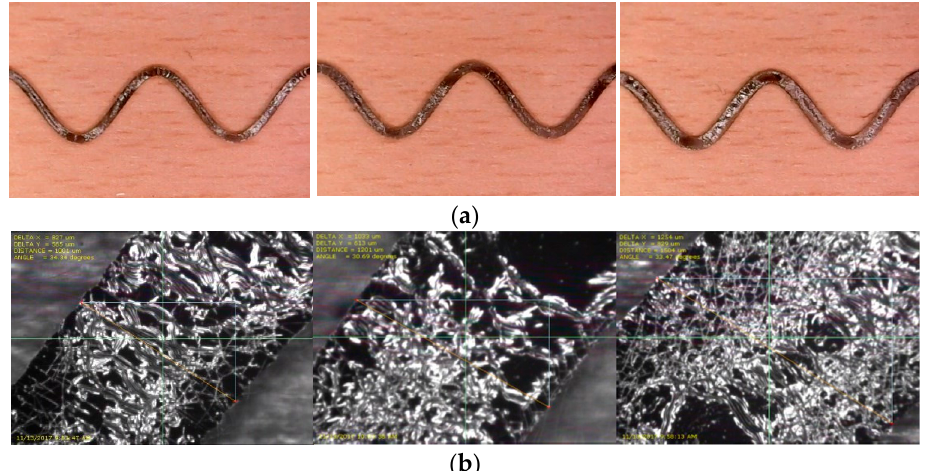
Figure 5. Examples of printed circuits. ( a ) Sinusoidal patterns printed at recommended parameters and widths of 1, 1.2, and 1.5 mm, respectively; ( b ) close up images of the circuits in ( a ) taken using the printer’s fiducial camera.